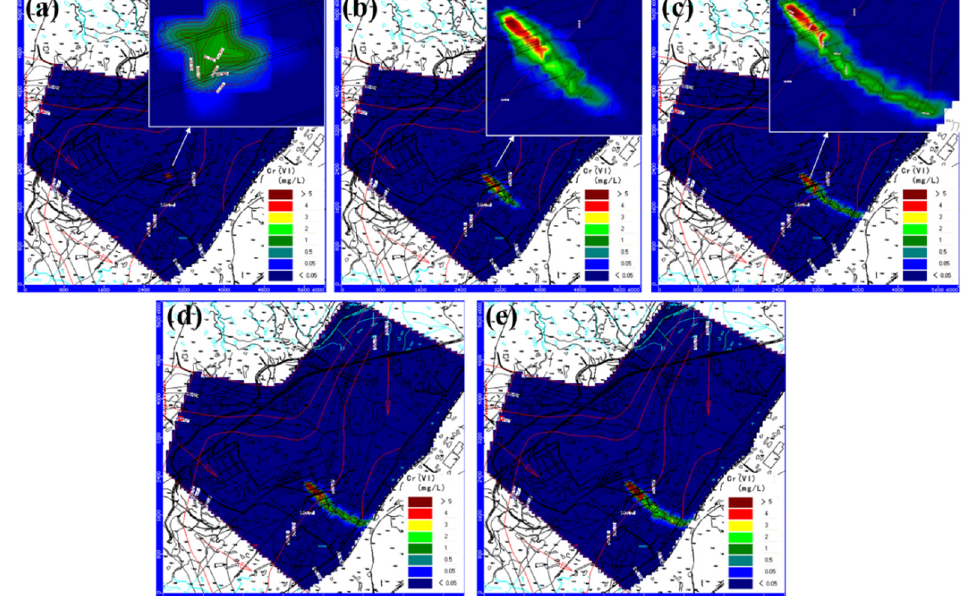
Figure 8. Simulation results of Cr(VI) in groundwater after ( a ) 10 days, ( b ) 1 year (1967), ( c ) 2 years (1968), and ( d ) 20 years (1986) since the initiation of the simulation and in ( e ) 2009. The simulation results showed that the range of Cr(VI) migration in the groundwater gradually increased with time. The pollution halo diffused along the flow direction of the groundwater to the Lianshui River (southeast direction). However, the amount of Cr(VI) that entered the soil and groundwater decreased correspondingly with the increase in Cr(VI) concentrations in Cr leached from the ground slag. Thus, the area of high concen- tration in the pollution halo had a downsizing trend in the last 25 years of the simulation. During the 45-year period of the simulation, the Cr(VI) pollution halo of the groundwater in the study site continuously spread out to the Lianshui River. Its downstream direction increased the Cr(VI) content of the groundwater in a large area of the study site to a level higher than the standard (0.05 mg/L). Consequently, the water quality in the Lianshui River was considerably affected. Given the presence of wells within the pollution halo, the health of the residents is threatened as well. Notably, the vertical thickness of the aq- uifuge is small, and Cr(VI) reached the bottom of the aquifer before the simulation was initiated. The vertical difference is imperceptible; thus, the Cr(VI) vertical distribution graph in the groundwater is not presented in this paper. Sampling analysis for the well water of the residents near this enterprise was per- formed for the second half of 2009 to verify the reliability of the simulation results. The results were compared with the predicted values for 2009 (Table 2). Table 2 shows that the maximum and minimum differences between the measured and predicted values were 1.158 and 0.001 mg/L, respectively. The maximum relative error (RE) was 31%, the mini- mum RE was 12%, the average error (ME) was 0.221, and the root mean square error (RMSE) was 0.430. As indicated by these results, the measured and predicted values basi- cally correspond. Therefore, the established mathematical model in this paper is reliable.